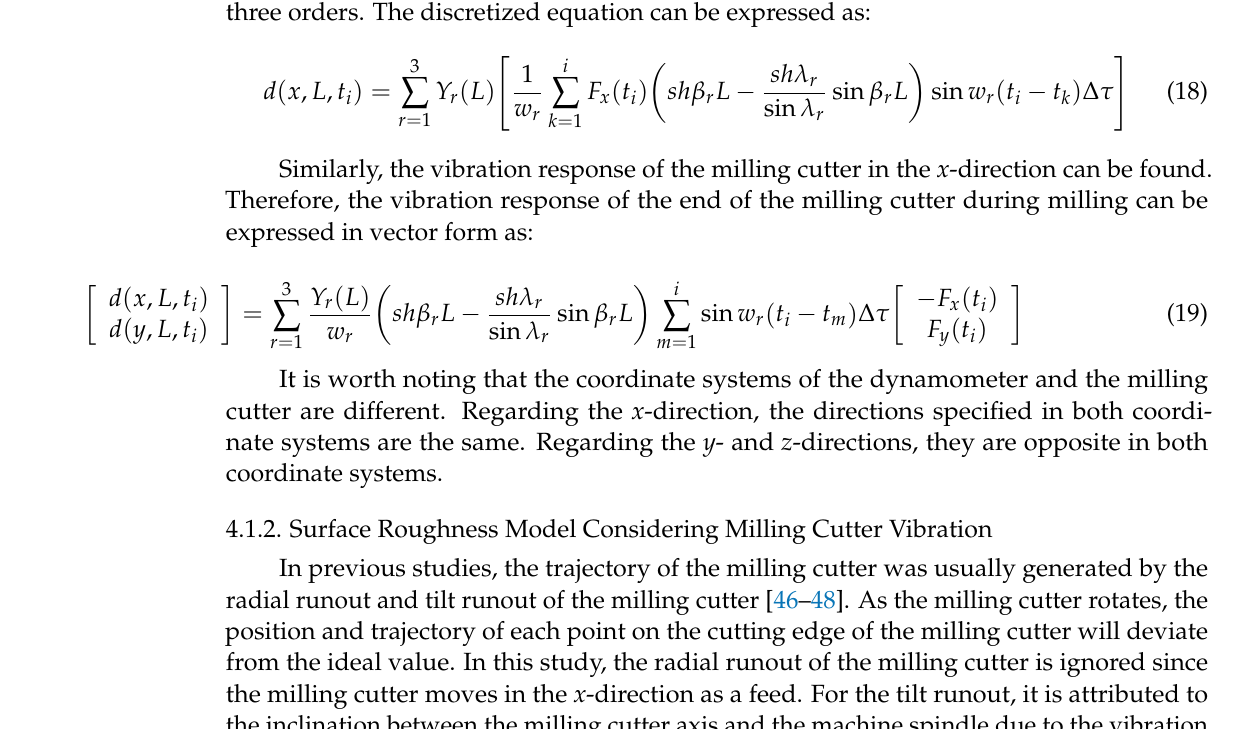
Figure 23. The discrete model of the milling force.